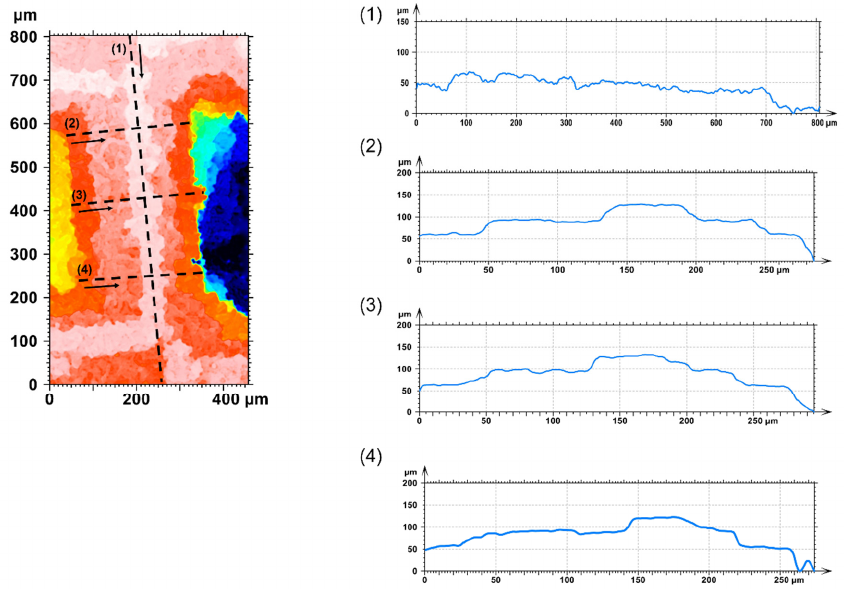
Figure 13. The surface topography image was obtained for one of the strun of the Voronoi structure after modification with DLC coating and roughness profiles (black arrows indicate the direction in which to draw the profile).